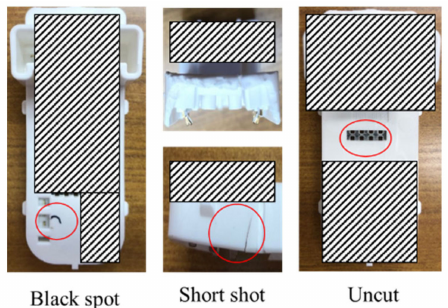
Figure 8. Target